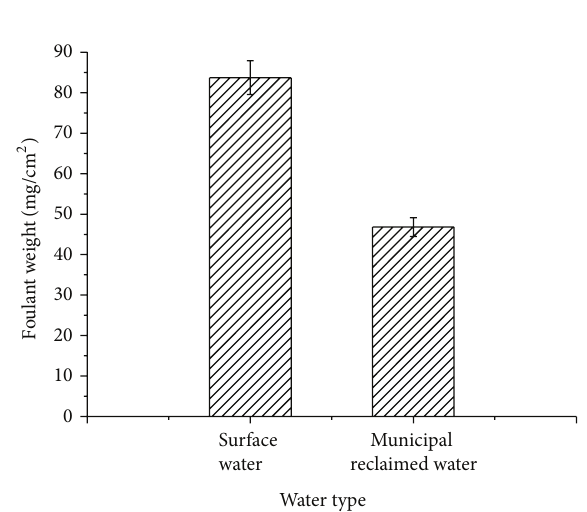
Figure 4: Weights of foulant in recycling cooling water system makeup by municipal reclaimed water and surface water. Note: unit of weight of foulant was wet weight of foulant per unit area of